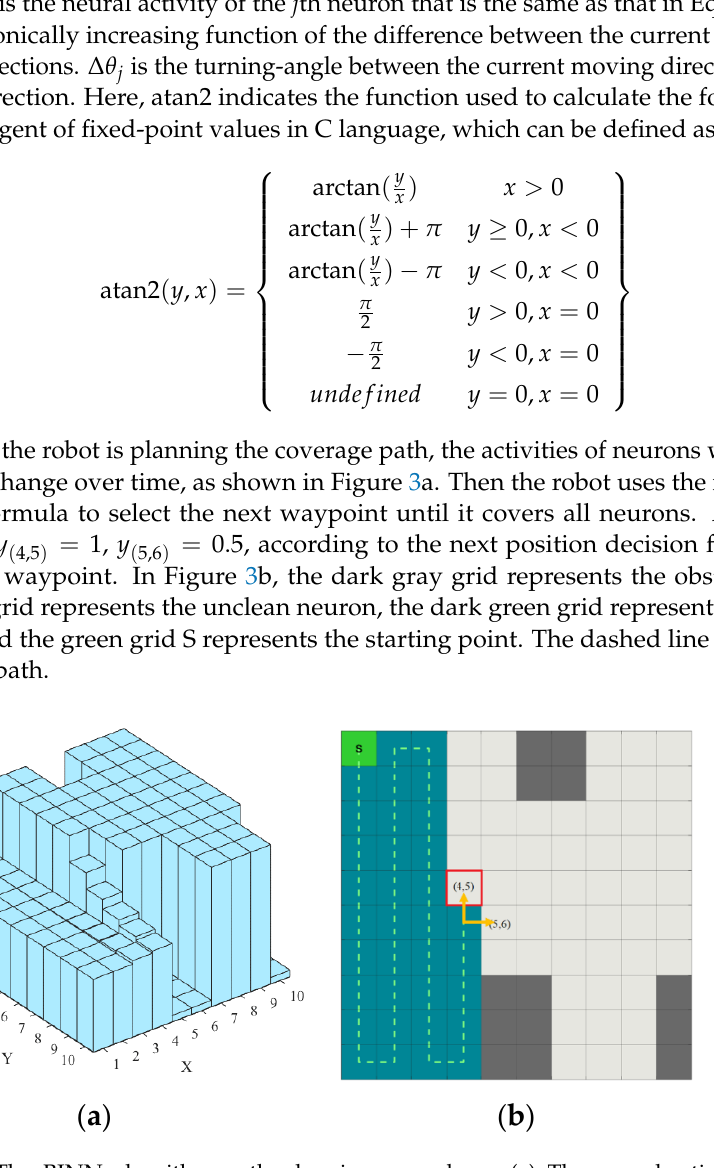
Figure 3. The BINN algorithm path planning procedure: ( a ) The neural-activity landscape ( b ) Progress of selecting the next position.